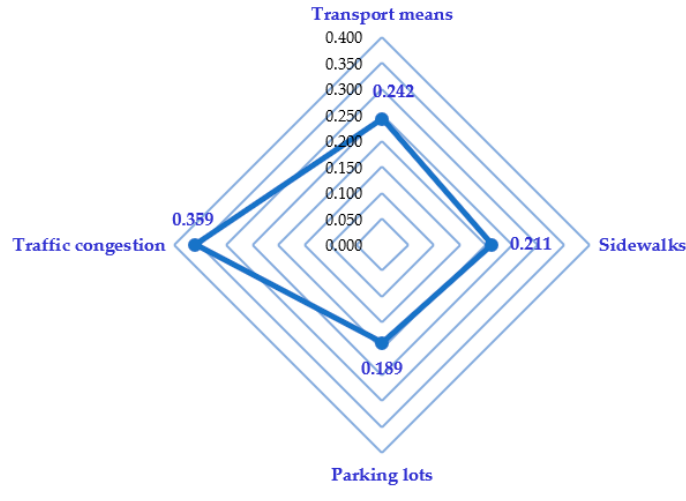
Figure 9. Relative weights of the assessment indicators for “Transport”.